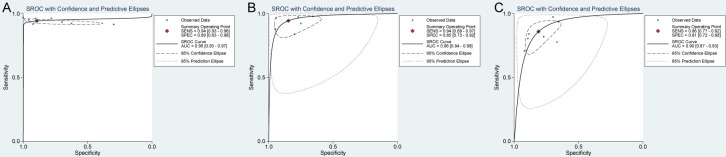
Summary receiver operation characteristic (SROC) curve of diagnostic performance of CNN system (A), expert (B), and non-expert (C) for CP classification.